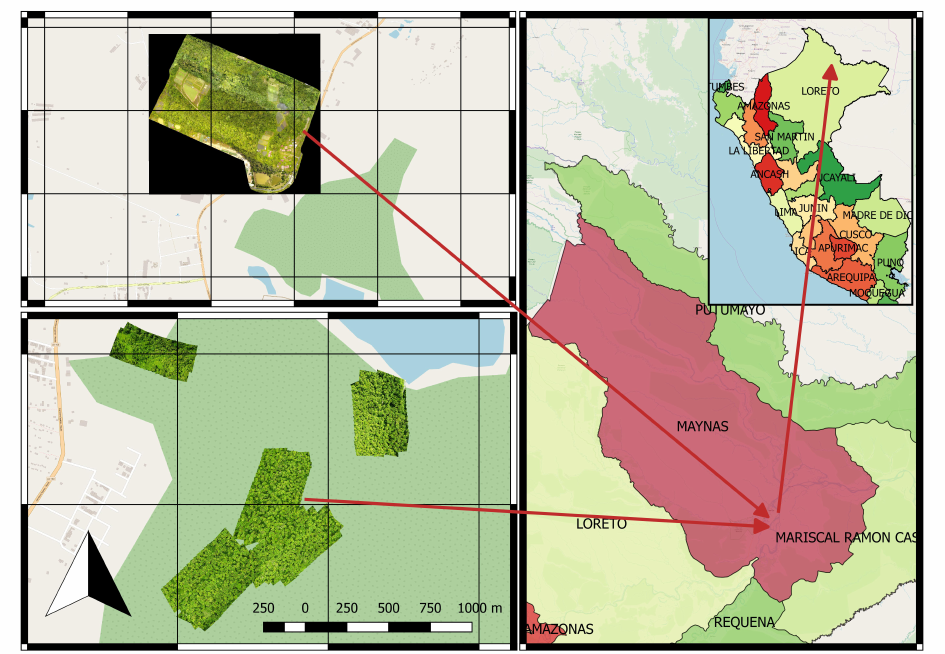
Figure 2. Study area in Iquitos City, Maynas Province, north of Peru.